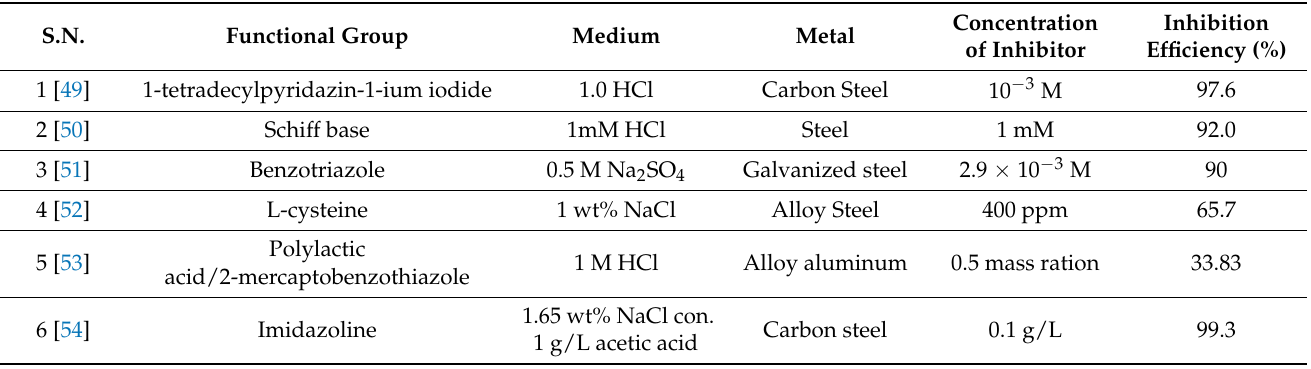
Table 1. Different chemically functionalized carbon-based anticorrosion coatings in aqueous phases.